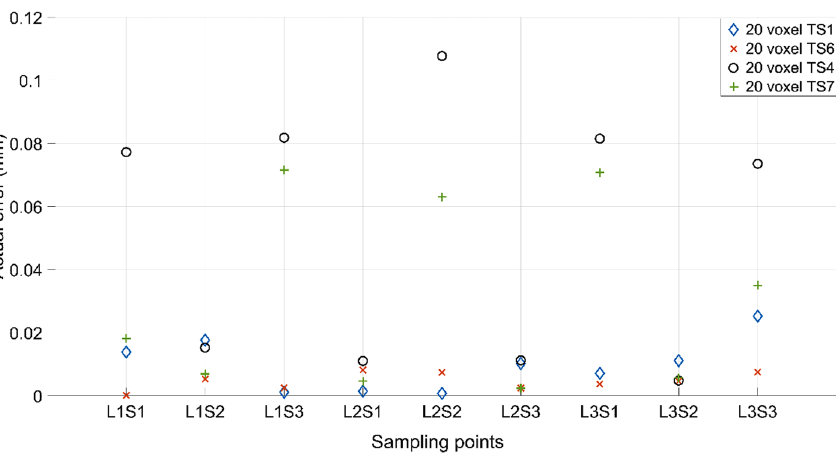
Figure 9. The mean of the absolute difference between the deflection from numerical results and the corresponding target deflection in the nine sampling